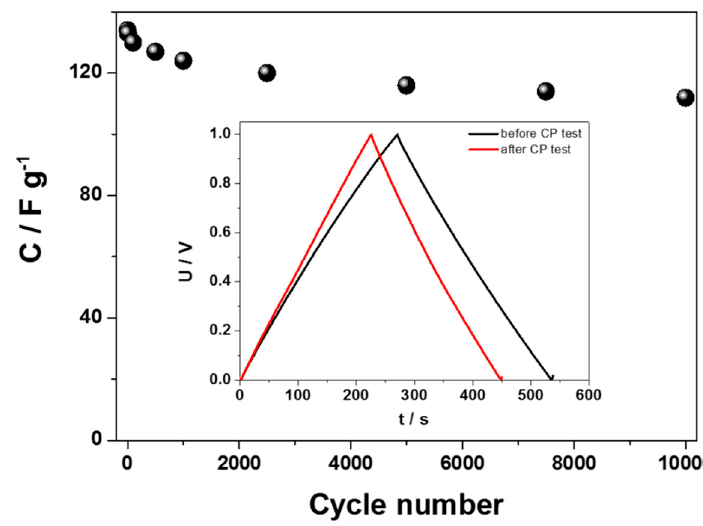
Figure 8. Curves of specific capacitance vs. cycle number for the hydrated non-crystalline WO 3 − x . Inset: exemplary galvanostatic charge–discharge curves of electrodes at 0.5 A g − 1 (in a two-electrode configuration).